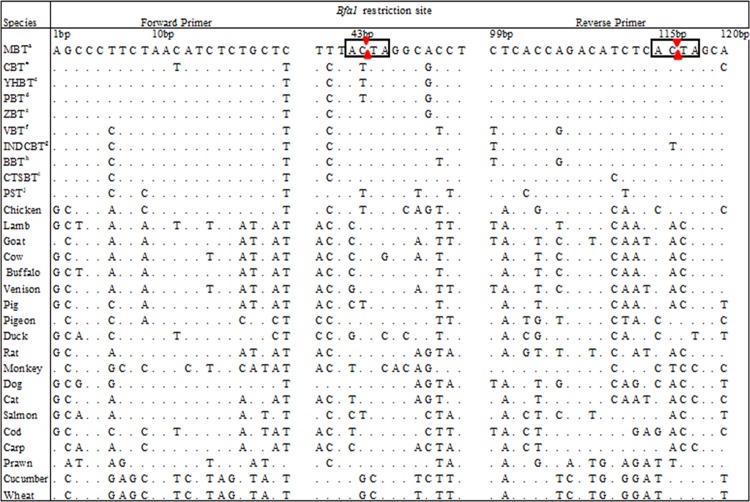
In silico analysis of the MBT-specific primers against 20 study species including 8 species of the Cuora genus with Bfa1-restriction sites.aCuora amboinensis-Malayan box turtle (MBT), bCuora flavomarginata-Chinese box turtle (CBT), cCuora aurocapitata-Yellow-headed box turtle (YHBT), dCuora pani-Pan’s box turtle (PBT), eCuora zhoui-Zhou's box turtle (ZBT), fCuora picturata-Vietnamese box turtle (VBT), gCuora galbinifrons-Indochinese box turtle (INDCBT), hCuora bourreti-Bourret’s box turtle (BBT), iCuora trifasciata-Chinese three-striped box turtle (CTSBT), and jTrachemys scripta-pond slider turtle (PST).